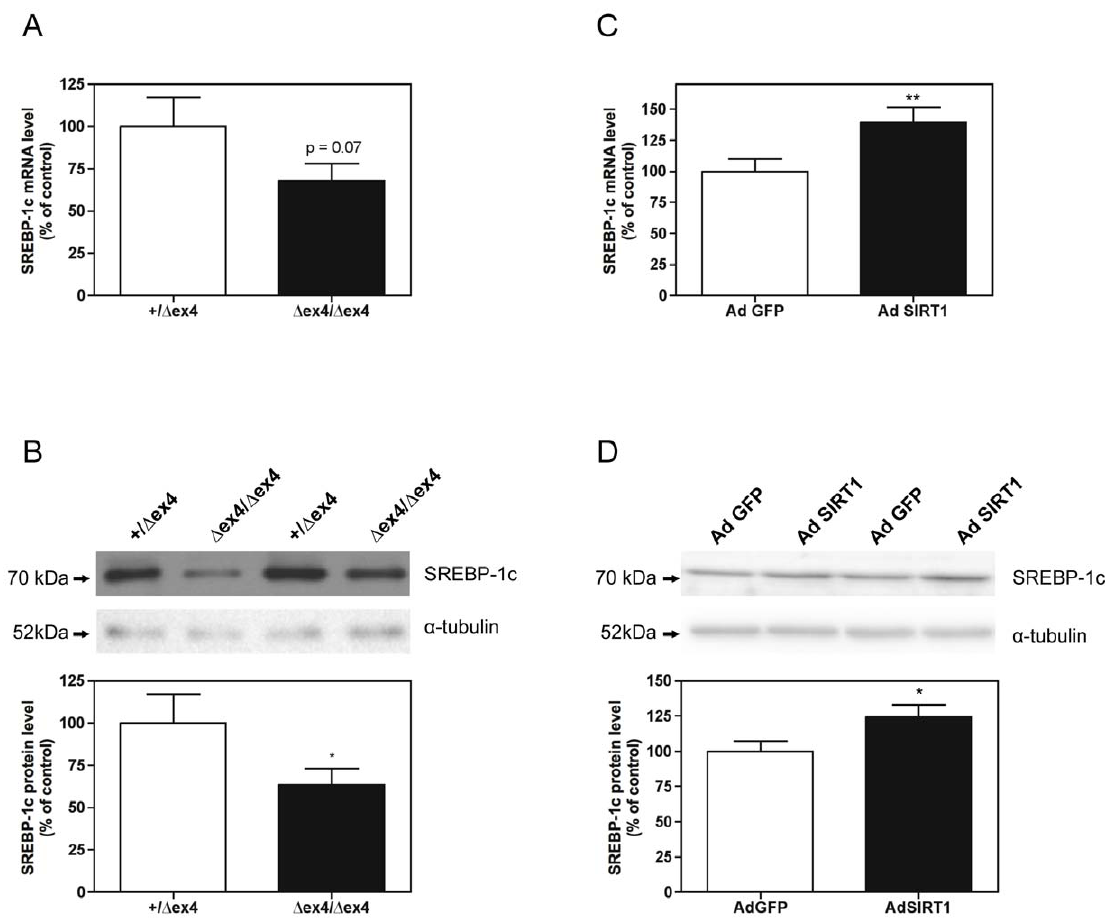
Figure 1. Sterol regulatory element binding protein (SREBP)-1c expression. (A) SREBP-1c mRNA level in the gastrocnemius muscle of SIRT1 + / D ex4 and SIRT1 D ex4/ D ex4 mice. (B) SREBP-1c protein level in the gastrocnemius muscle of SIRT1 + / D ex4 and SIRT1 D ex4/ D ex4 mice. (C) SREBP-1c mRNA level in human myotubes (7 days of differentiation) infected for 48 hours with recombinant adenovirus expressing either green fluorescent protein (AdGFP) or sirtuin 1 (AdSIRT1). (D) SREBP-1c protein level in human myotubes (7 days of differentiation) infected for 48 hours with AdGFP or AdSIRT1. For western blot analyses, equal protein loading was controlled by measuring total protein content and a -tubulin expression by western blot. Data are expressed as means 6 SE (n=4/group for animal study; n=5/group for in vitro study). ** P , 0.01 and * P , 0.05: significantly different from the corresponding control condition.